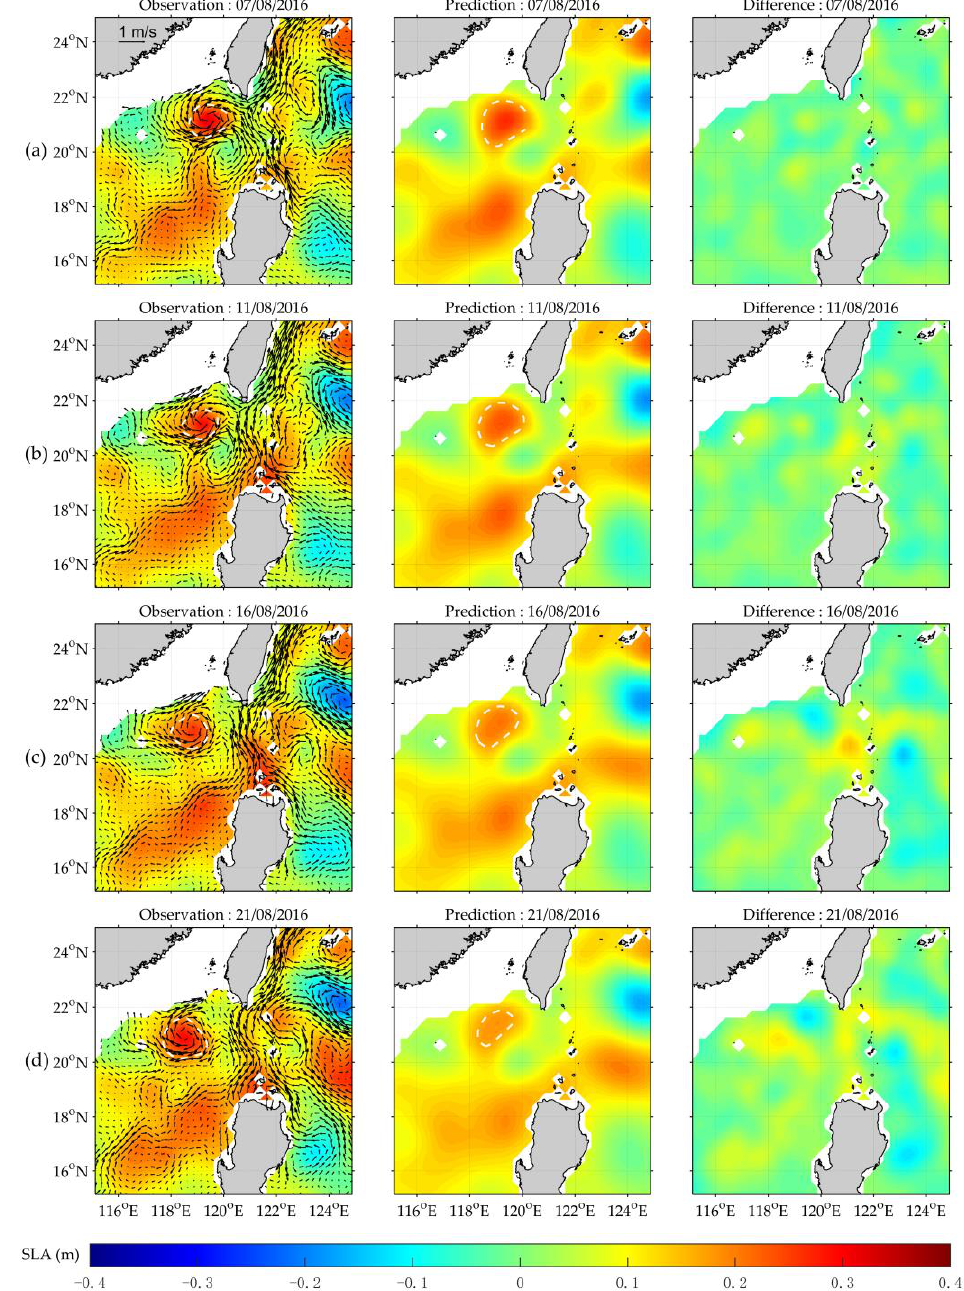
Figure 13. Comparison between observed and predicted SLA at ( a ) day 1, ( b ) day 5, ( c ) day 10, ( d ) day 15. The white dashed line represents the counters of 0.19 m and 0.17 m for observation and prediction, respectively. The red area around the white dashed line is the anticyclone eddy. The left column shows the results from observation, the middle column shows the results from the prediction model, and the right column shows the difference between the observed and predicted SLA . Black vectors are the variation of geostrophic current.